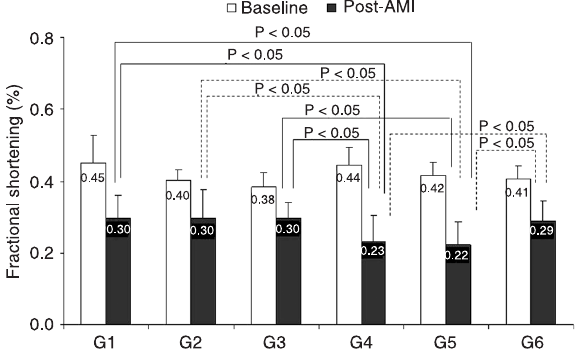
Figure 2. Fractional shortening of left ventricle. See Figure 1 for protocol. There was significant decrease in fractional shortening from baseline to the post-acute myocardial infarction condition in all groups. The variables measured in only one condition were evaluated by analysis of variance (ANOVA) with a classification factor, when significant. The Tukey test was applied to determine differences between groups. AMI = acute myocardial infarction.